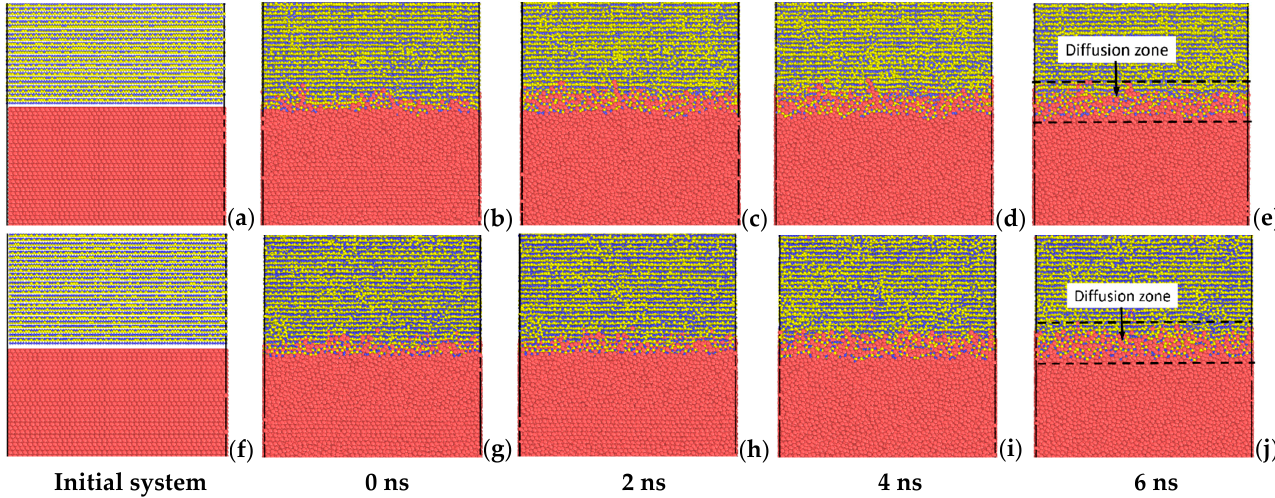
Figure 1. Cross-sectional views of the atomic configurations of the C-terminated ( a ) to ( e ) 6H-SiC/Al and ( f ) to ( j ) 3C-SiC/Al interfaces with 20% vacancy in SiC. The figure shows atomic structures at 300 K before relaxation and the configurations after maintaining the systems at 1000 K for 0, 2, 4, and 6 ns.